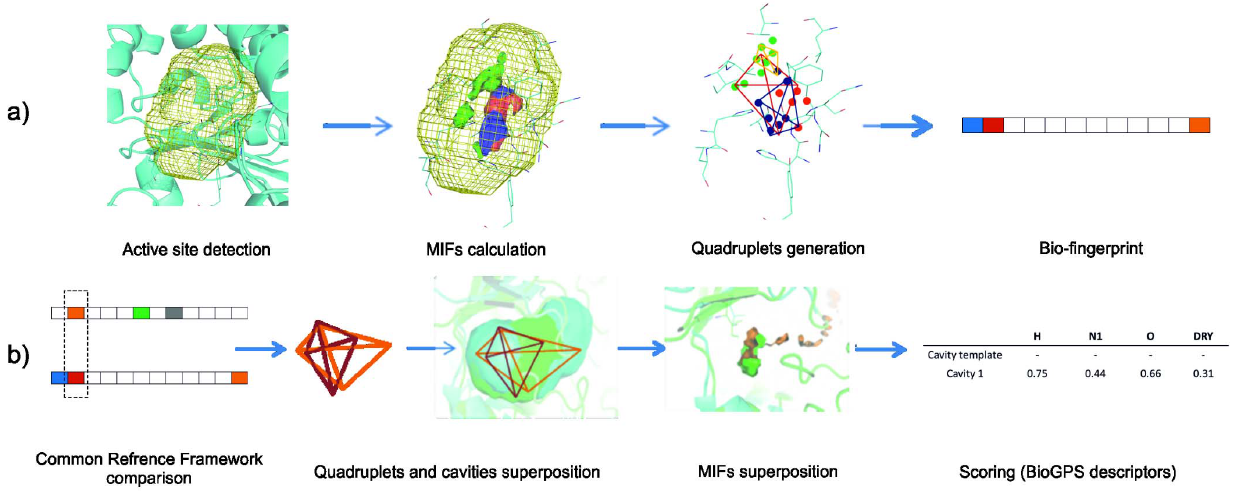
Figure 2. Schematic illustration of the generation of BioGPS molecular descriptors. (a) Starting from the GRID mapping of enzyme active site the BioGPS algorithm identifies points used for generating quadruplets and a Common Reference Framework. (b) In order to compare two cavities (active sites), the algorithm searches for similar quadruplets and then overlaps the corresponding 3D structures (all against all approach). At the end a series of probe scores is generated.